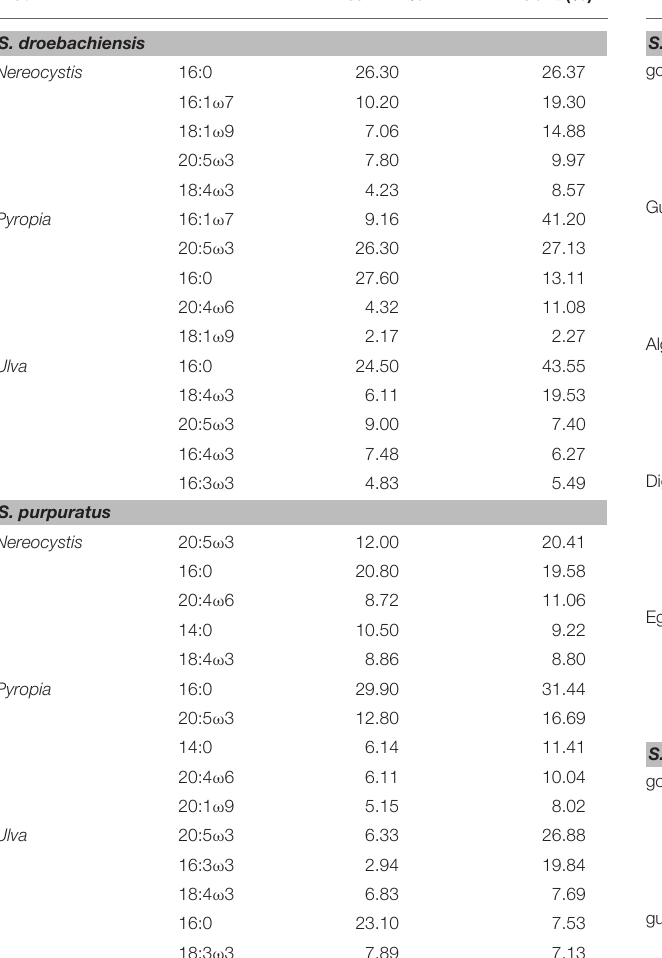
TABLE 4 | SIMPER results for analysis of combined FA of tissues from S. droebachiensis ( N = 12) and S. purpuratus ( N = 18). Diet FA Mean FA % Cont (%)